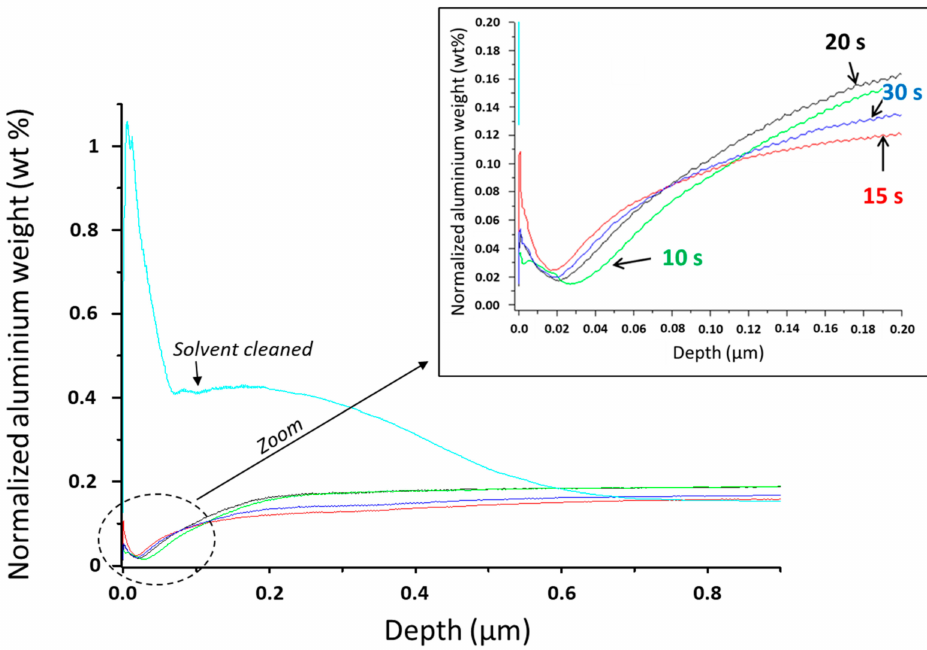
Figure 4. Aluminum depth profile after solvent cleaning (light blue) and after alkaline cleaning (black, green, red, and blue) with the alkaline solution (KOH) pH > 13 (10, 15, 20, 30 s) between 0 and 0.8 µ m and between 0 and 0.2 µ m